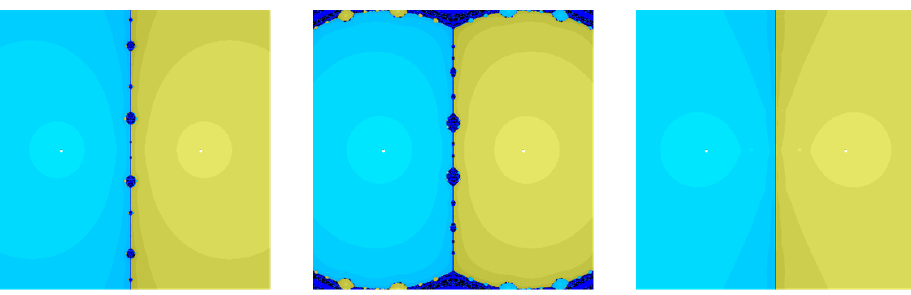
Figure 2. Attraction basins for Padé 1–2 on the left, Padé 1–3 in the middle and Padé 1–4 to the right.